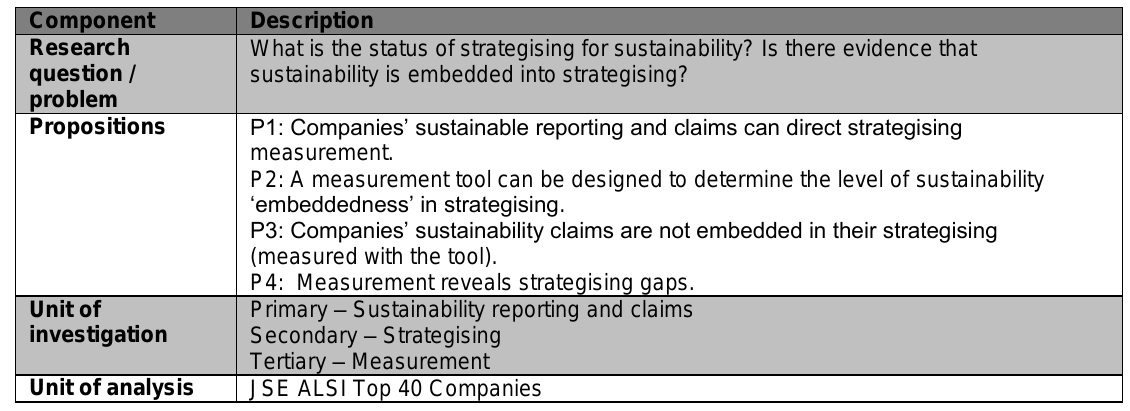
Table 1: Research design